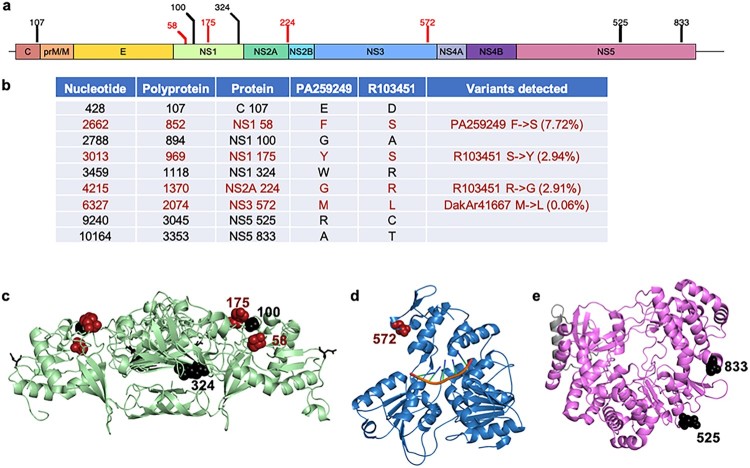
SNVs were detected in four of the nine consensus sequence changes between strains PA259249 and R103451. A) Genome schematic depicting the amino acid differences between strains PA259249 and R103451, red: denotes positions of SNVs in the dataset across lineages. B) Nucleotide, polyprotein, and protein number of coding differences between the two strains, as well as the variants detected (% denotes frequency of SNV) are listed. Structural depiction of each consensus coding change, in black, or consensus coding change with SNV detected, in red, for the NS1 dimer (C), NS3 helicase (D), and NS5 polymerase (E). No structure is available for amino acids C 107 and NS2A 224.